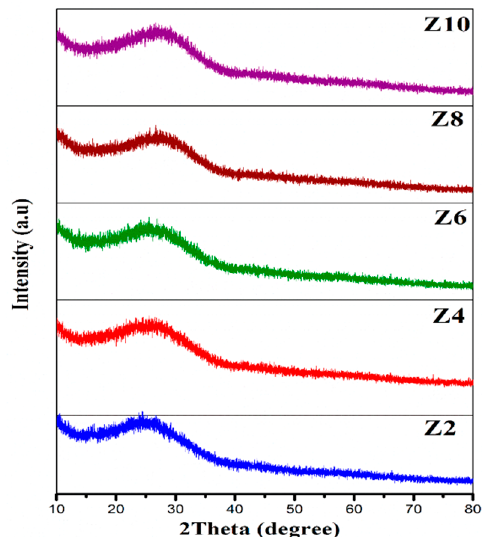
Figure 4. X-ray diffraction patterns of Z2, Z4, Z6, Z8 and Z10 glasses. Figure 4. X-ray di ff raction patterns of Z2, Z4, Z6, Z8 and Z10